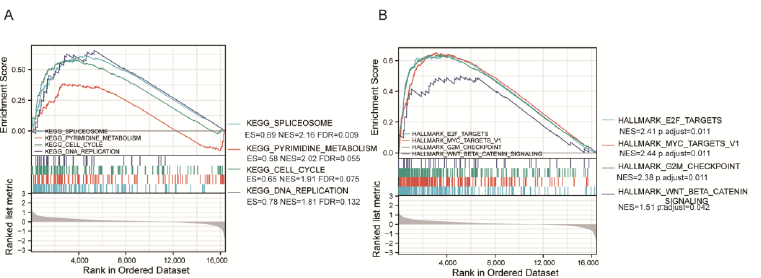
Figure 6. GSEA analyses of RPS24 expression in LIHC. ( A )The four KEGG signaling pathways were markedly enriched with the high expression of RPS24, including the spliceosome, pyrimidine metabolism, cell cycle, and DNA replication. ( B )The four HALLMARK pathways were significantly enriched with the high expression of RPS24, including the E2F targets, MYC targets, G2M-checkpoint- related pathways, and Wnt/ β -catenin signaling.2.6. Immune infiltration analysis of RPS24 in HCC.